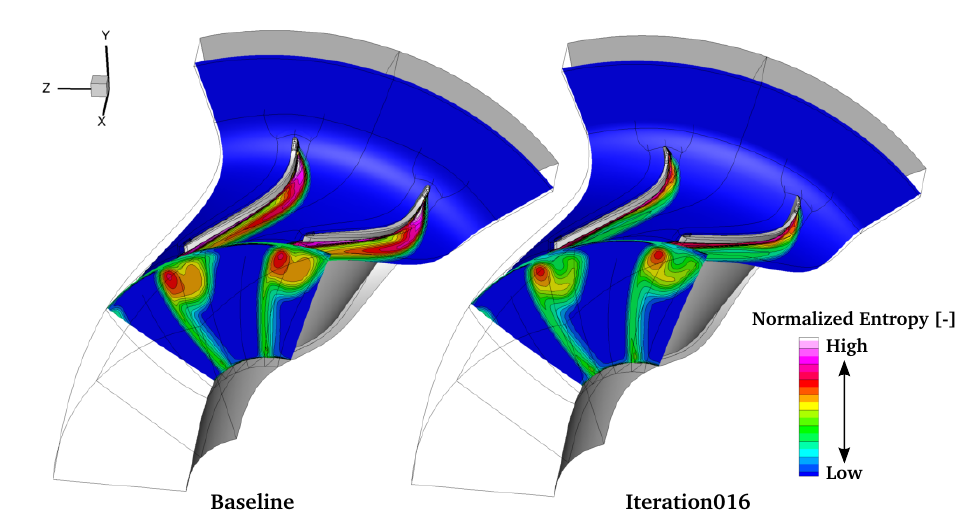
Figure 15. Comparison of normalized entropy at 90% span of the baseline and the optimized geometry (Iteration016) at operating point OP1.